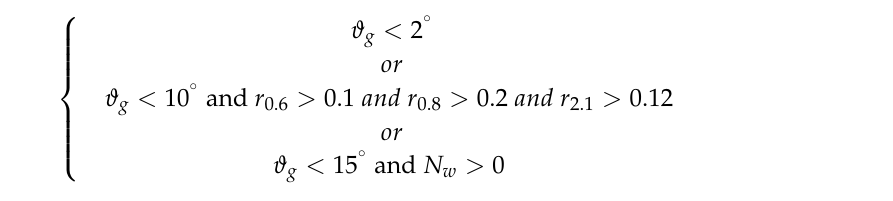
Figure 3. Sun glint, angle of reflectance (picture from the https://solarprofessional.com/articles/ design-installation/evaluating-glare-from-roof-mounted-pv-arrays/page/0/1#.WvN5oH_OOUk).